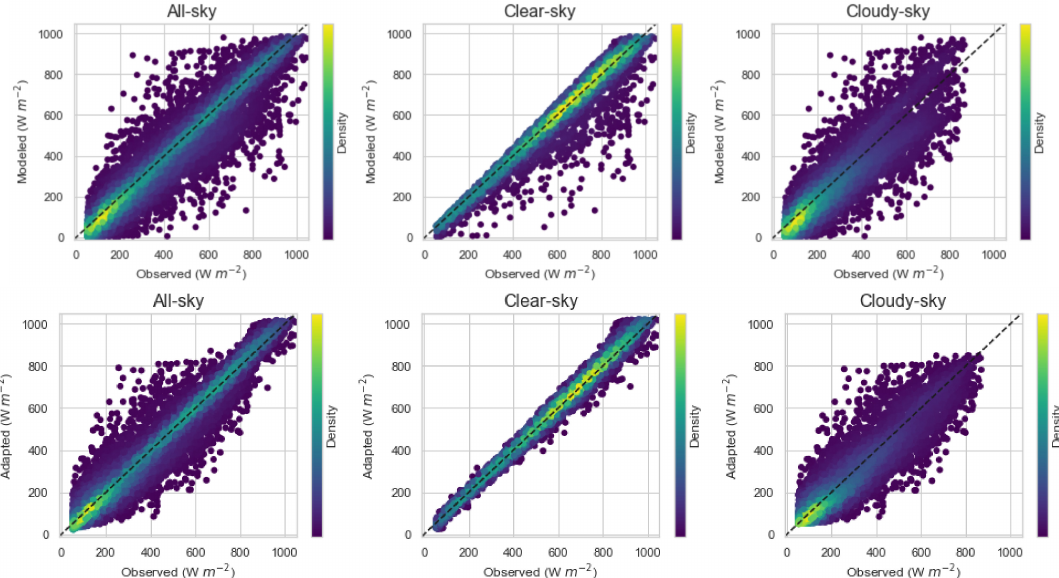
Figure 3. Scatter plots of GHI between satellite estimates and ground observation in the initial state ( top ) and after site adaptation using the best technique ( bottom ). The perfect correlation line is indicated by the black dashed line.